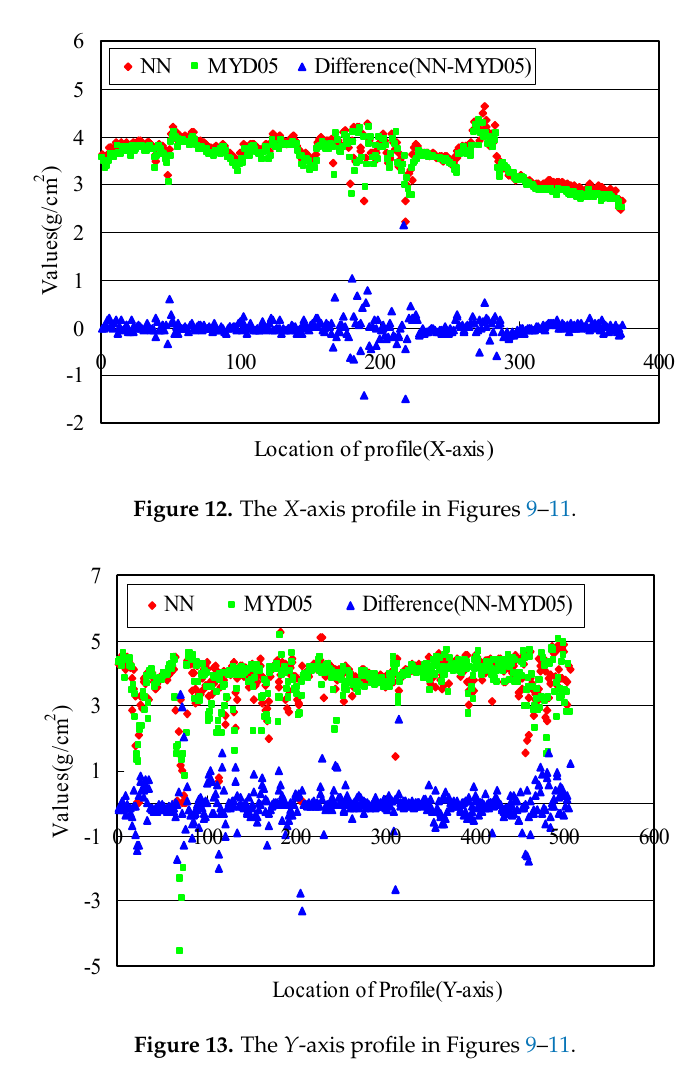
Figure 11. The difference between Figures 10 and 11.